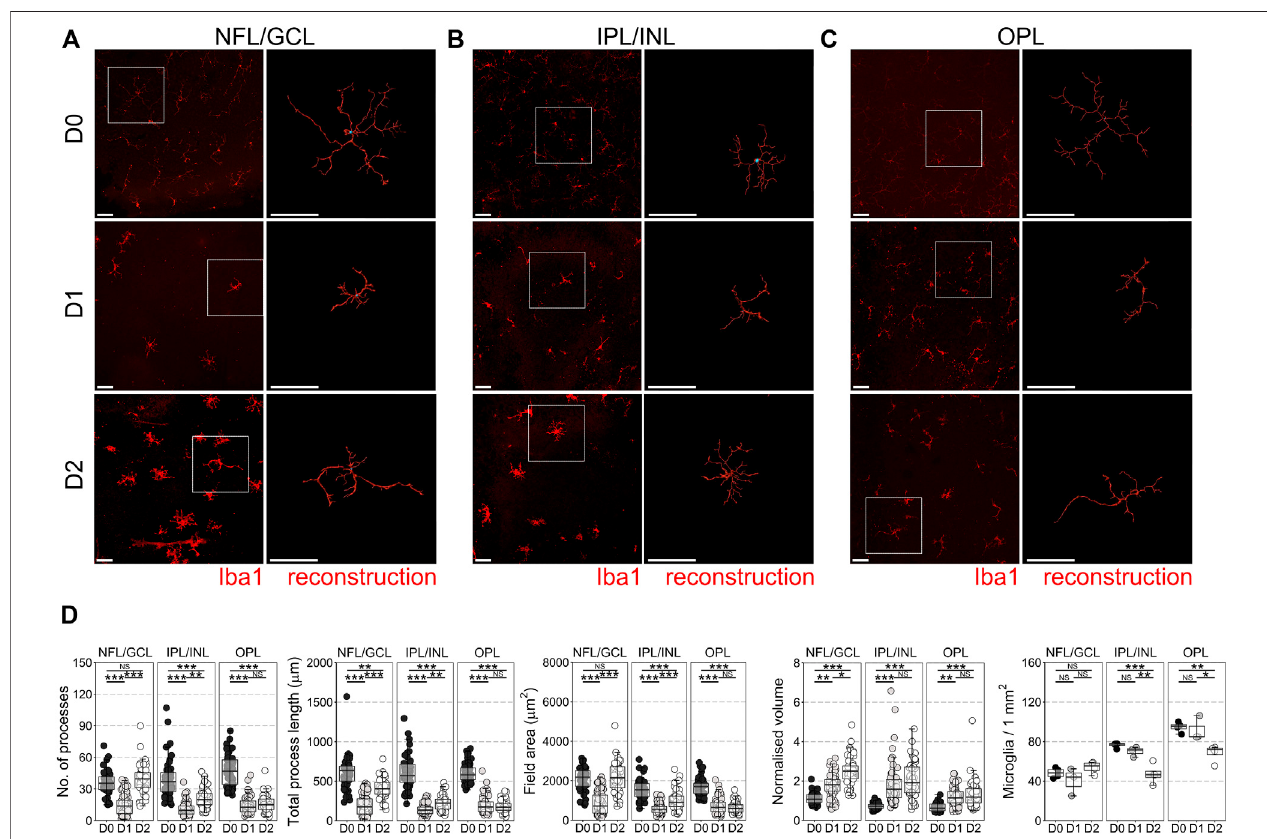
FIGURE1| Microglialmorphologicalchangesassociatedwith pro-in fl ammatory phenotypes occurin allretinalmicroglia niches inretinal explants.Retinalexplants were maintained for 1 day (D1) or 2 days (D2) ex vivo and compared to D0 controls (eyes fi xed immediately after enucleation). IBA1 labeled microglia were imaged and individually reconstructed using Imaris software from the three retinal microglia niches (A) nerve fi ber layer/ganglion cell layer (NFL/GCL) (B) inner plexiform layer/inner nuclear layer (IPL/INL), and (C) outer plexiform layer (OPL). (D) Across all microglial niches, at D1 there was a signi fi cant reduction in the number of microglia processes, total process length, fi eld area, and normalized volume, demonstrating that microglia became less complex and more voluminous, as occurs with a shift towards pro-in fl ammatory phenotypes. The degree of change was no greater in any one layer, suggesting a global retinal in fl ammatory environment. There was no signi fi cant difference in microglial density within niches demonstrating that there is no active proliferation, migration, or apoptosis of microglia by D1. By D2, microglia in the NFL/GCL had signi fi cantly increased number of microglia processes, total process length, fi eld area, and normalized volume, demonstrating an outgrowth of processesreminiscentofmicrogliaincellculture.ThiswassimilarintheIPL/INL,butnotintheOPL.Iba1=microgliaspeci fi cmarker, n =4retinasforallconditions,scale bars = 50 μ m, * = p < 0.05, ** = p < 0.01, *** = p < 0.001, NS = non-signi fi cant.